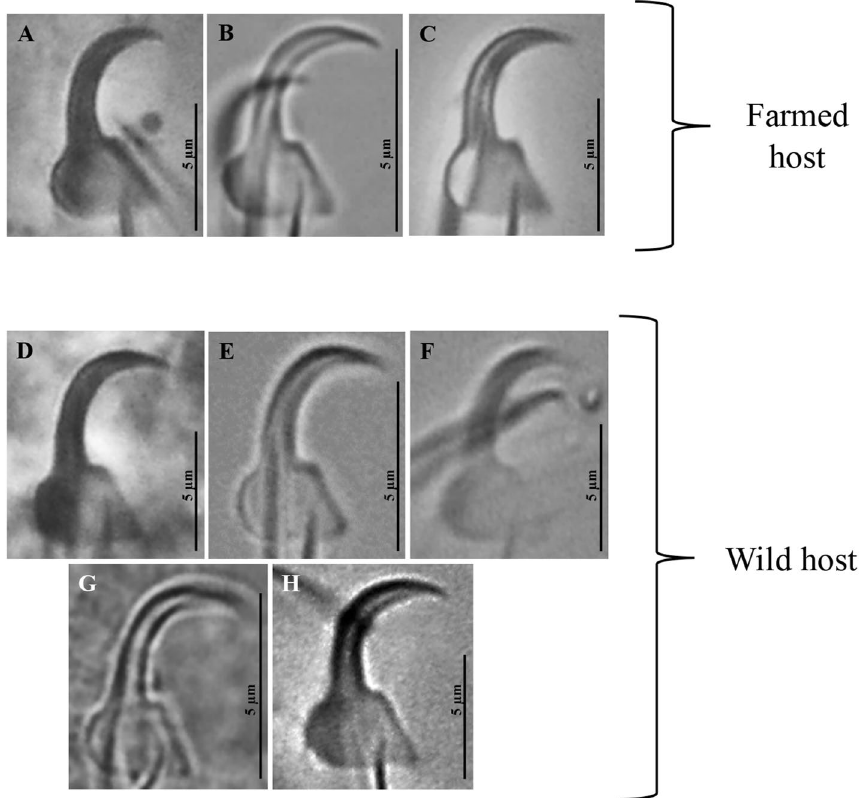
Figure 2. Micrographs of the marginal hook sickles of Gyrodactylus cichlidarum found infecting farmed “tilapia” and different native cichlids and poeciliids in Mexico. ( A ) Oreochromis niloticus , from Sonora. ( B ) O. niloticus , Yucatán. ( C ) O. niloticus , Chiapas. ( D ) Paraneetroplus nebuliferus . ( E ) Vieja fenestrata . ( F ) Poecilia mexicana . ( G ) Poeciliopsis gracilis . (H) Pseudoxiphophorus bimaculatus . Image H reprinted from Veterinary Parasitology, Vol 235, García-Vásquez A, Razo-Mendivil U & Rubio-Godoy M, Triple trouble? Invasive poeciliid fishes carry the tilapia pathogen Gyrodactylus cichlidarum (Paperna, 1968) in the Mexican highlands, Pages No. 37–40., Copyright (2017), with permission from